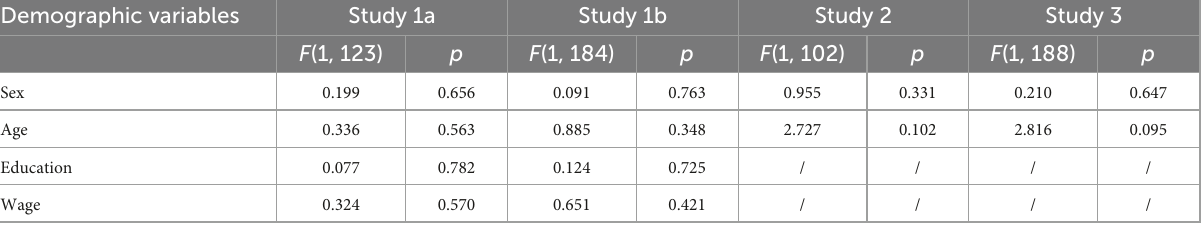
TABLE 1 Balancing test results for all studies.